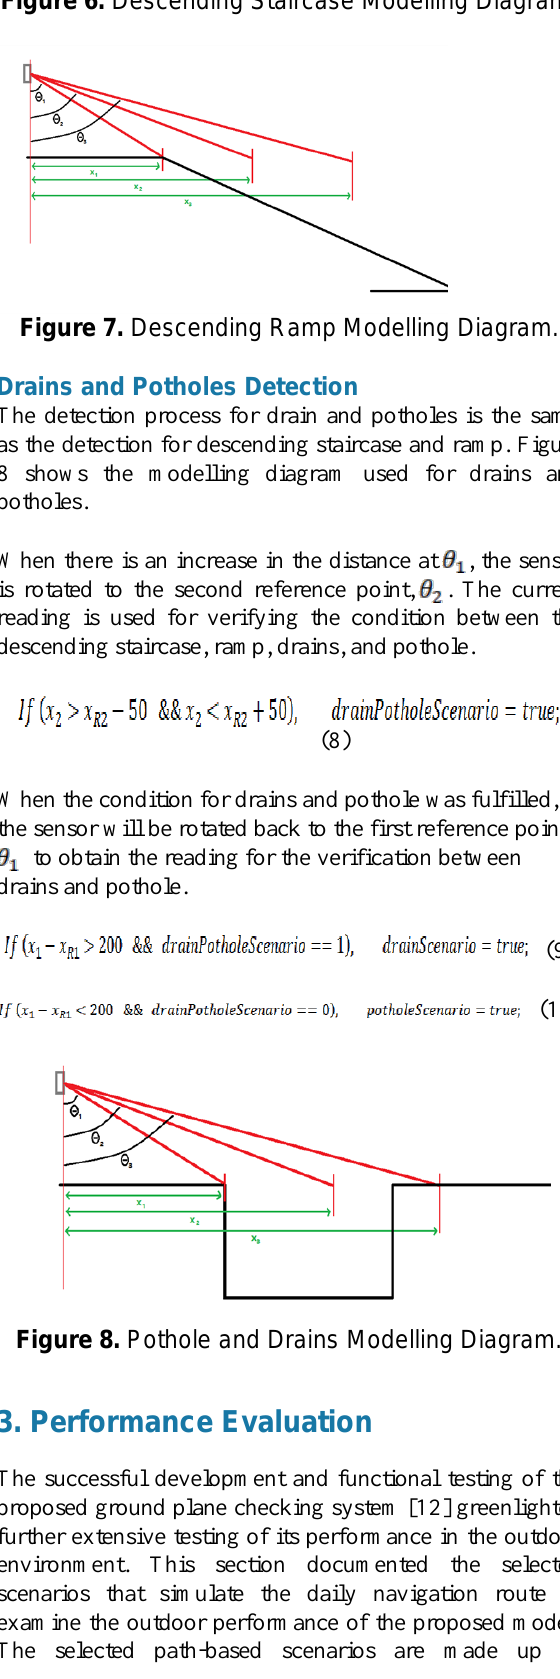
Figure 6. Descending Staircase Modelling Diagram.